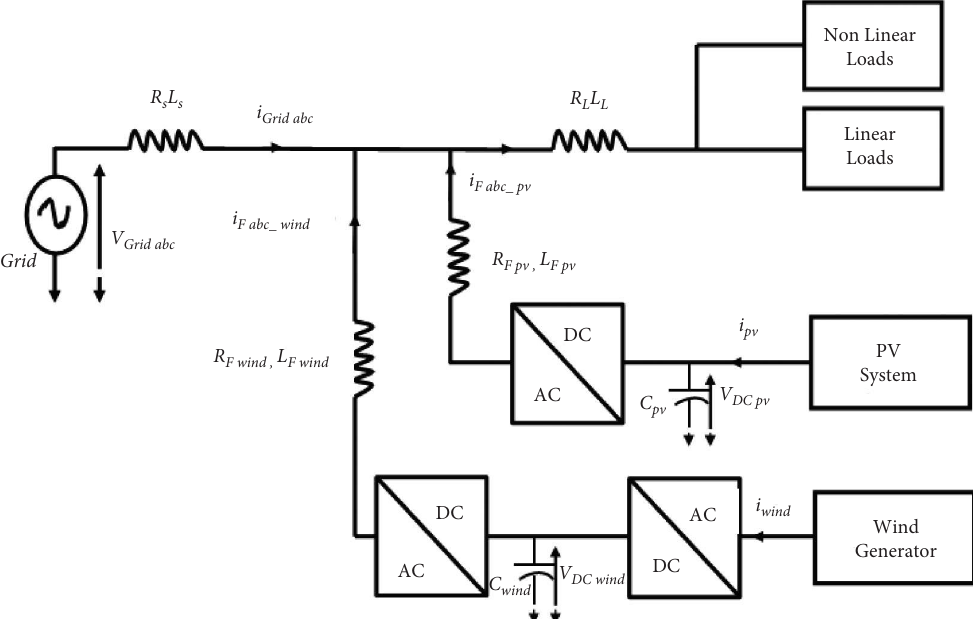
Figure 1: Block diagram of hybrid renewable energy system based on SAPF proposed.